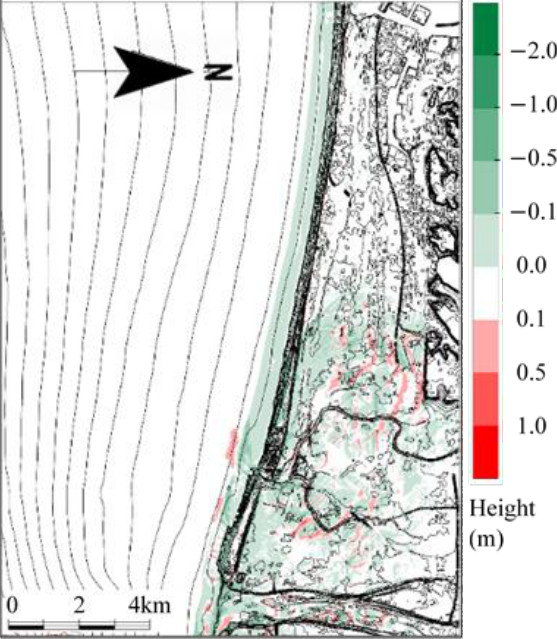
Figure 19. Topography change due to suspension load only, 28 min after the start of calculation (present condition).